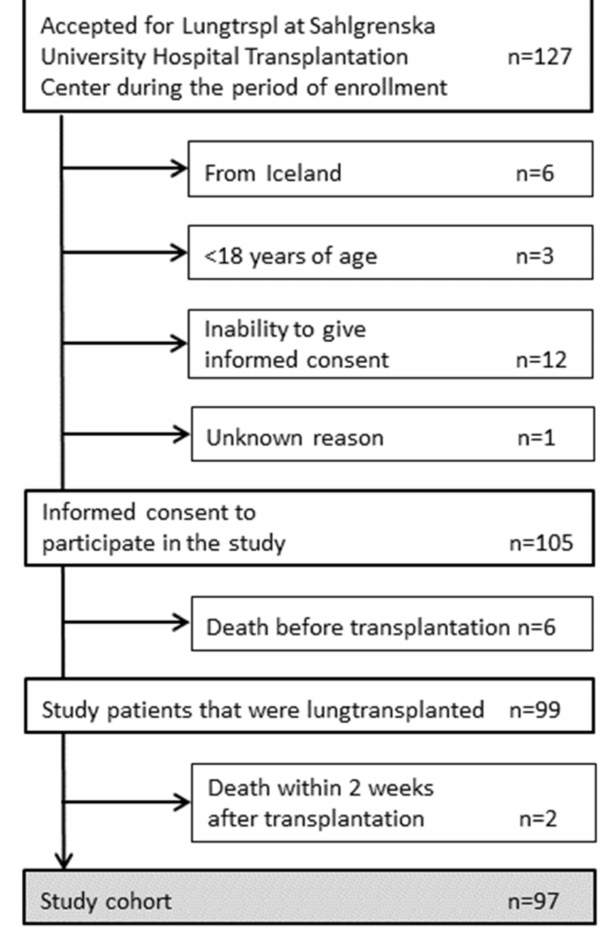
Figure 1. Inclusion of study